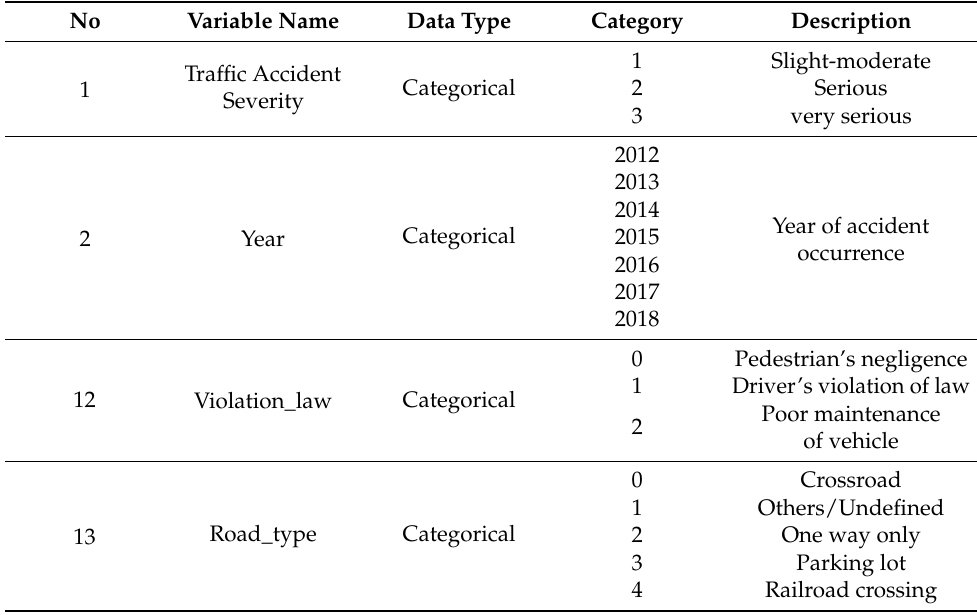
Table 1. Pre-processing results of Traffic accident information